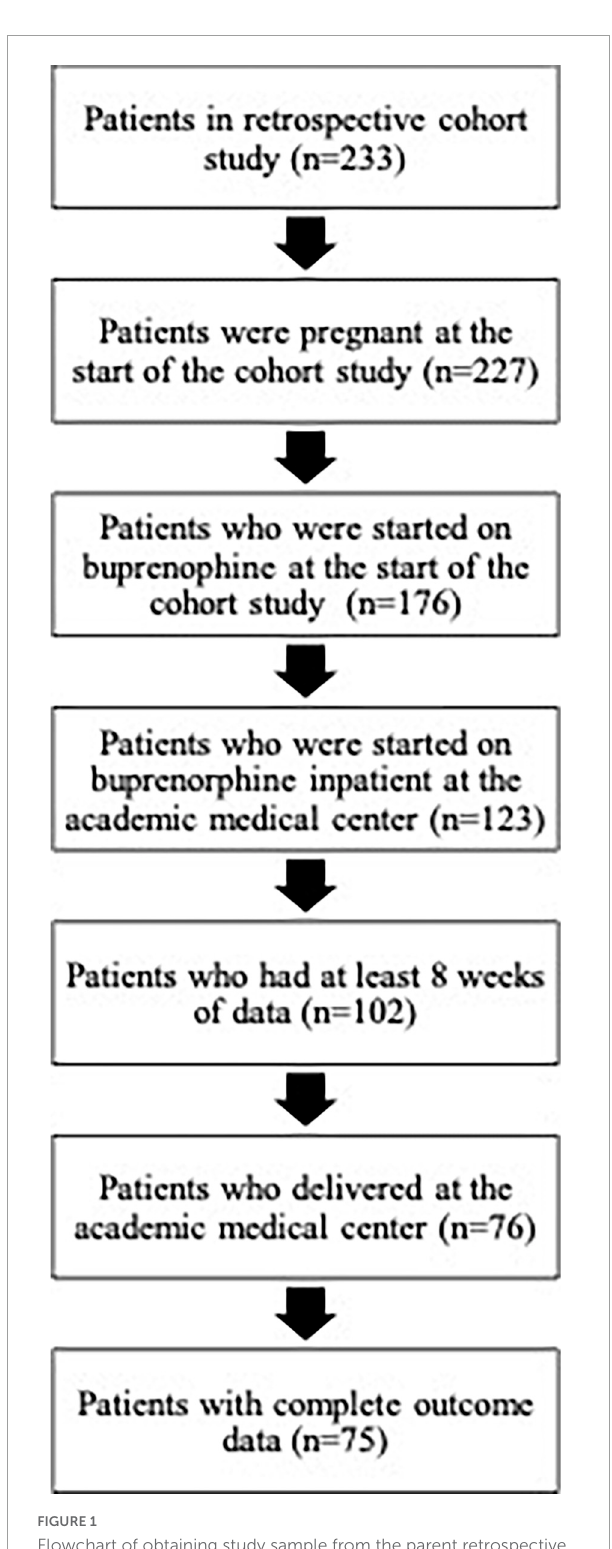
FIGURE1 Flowchart of obtaining study sample from the parent retrospective cohort study through exclusion criteria.